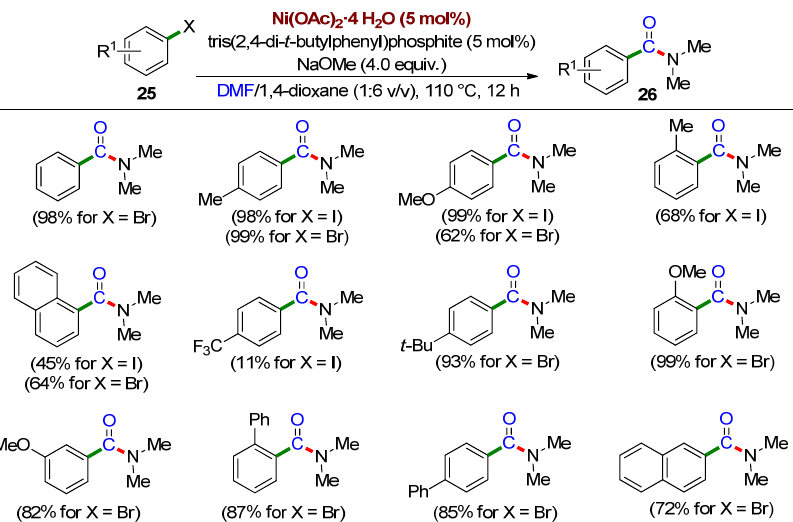
Scheme 10. Ni-catalyzed aminocarbonylation of aryl iodides/bromides 25 , using DMF as the source of CO and N , N -dimethylamino groups, reported in 2007 by Lee and co-workers [37]. For each carbonylated product 26 , yield after column chromatography purification was reported in brackets.